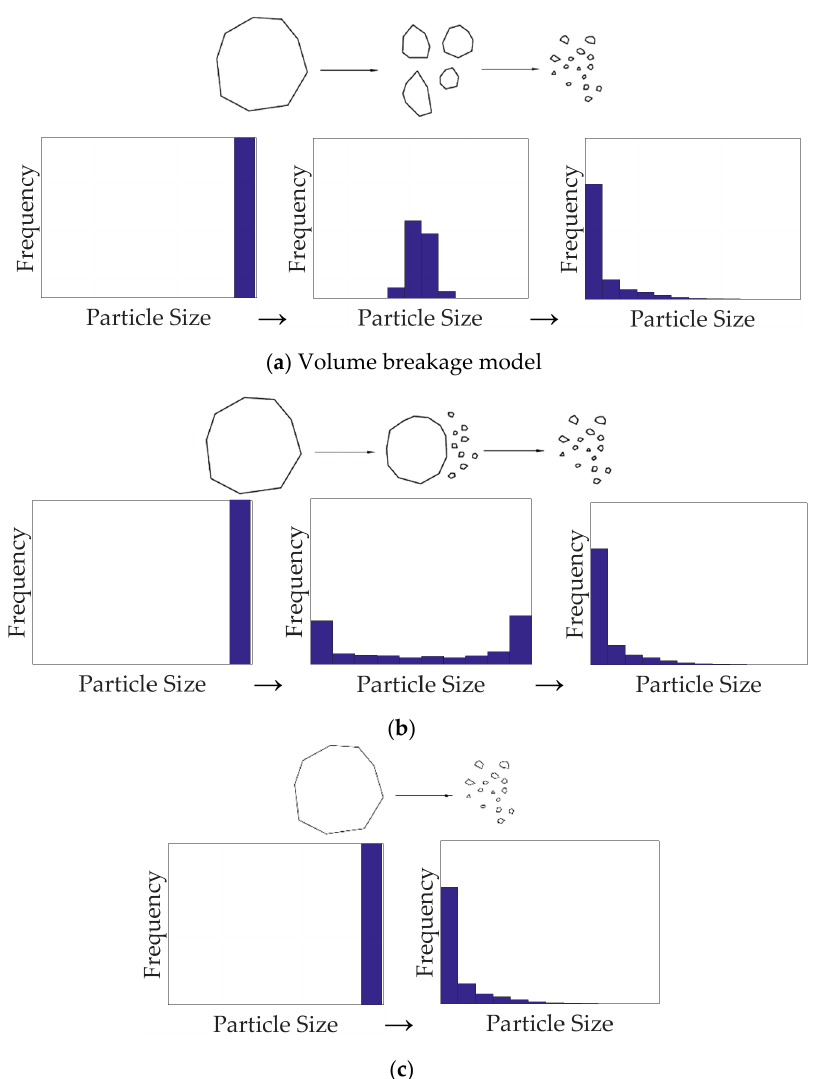
Figure 8. Changing particle size and mass fraction according to typical breakage models: ( a ) Volume breakage model; ( b ) Surface area breakage model; ( c ) Uniform breakage model.